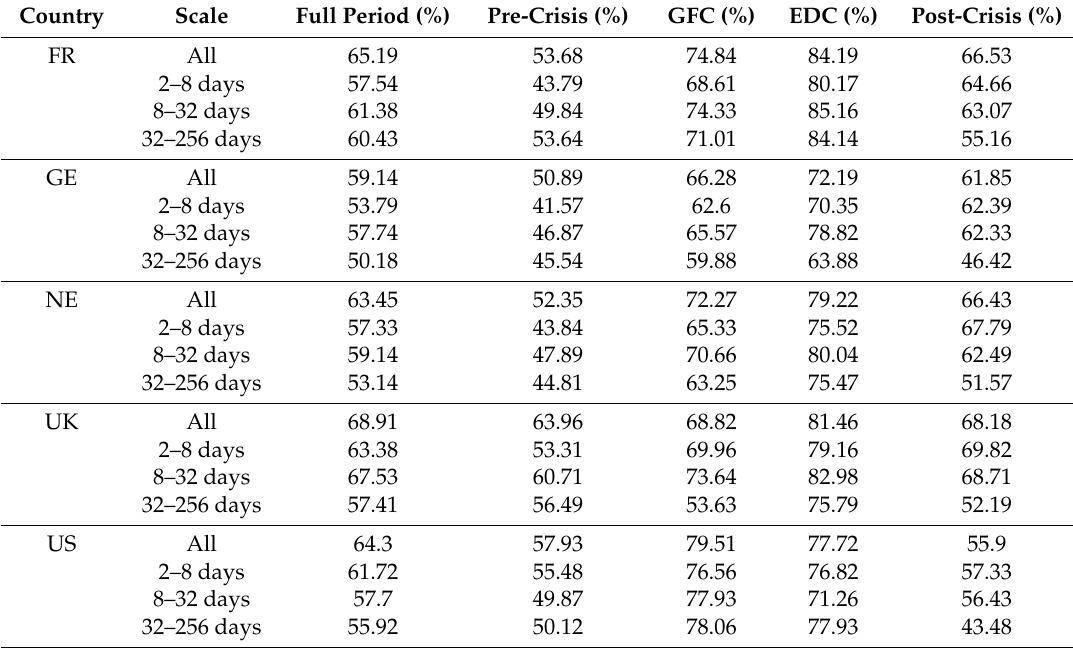
Table 4. Percentage of total volume (PTV) of wavelet coherence between real estate and stock markets for each country. Country